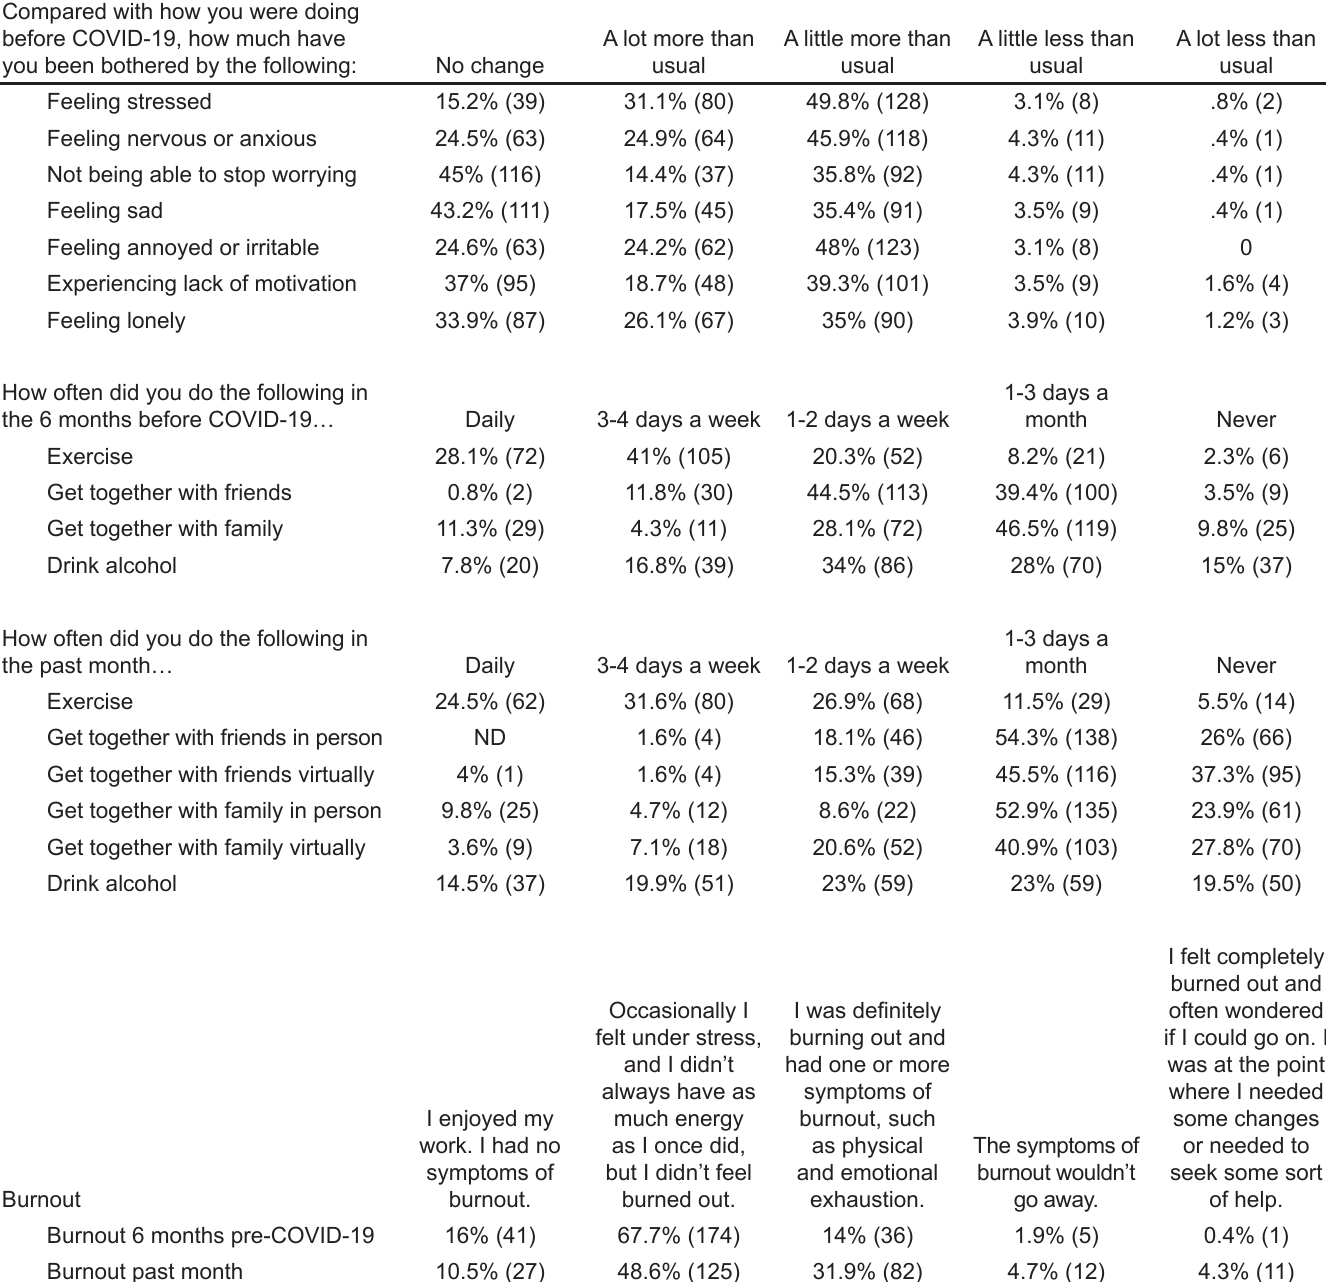
Table 2. Mental and behavioral health before and during the